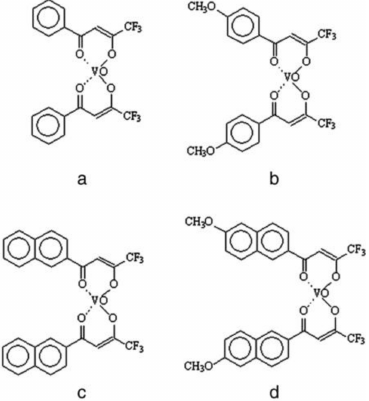
Figure 1. Structural formulas of complexes ( a – d ). ( a ) 1-phenyl-4,4,4-trifluorobutane-1,3-dione; ( b ) 1- (4-methoxyphenyl)-4,4,4-trifluorobutane-1,3-dione; ( c ) 1-(2-naphtyl)-4,4,4-trifluorobutane- 1,3-dione; ( d ) 1-(6-methoxy-2-naphtyl)-4,4,4-trifluorobutane-1,3-dione. Vanadyl complexes were synthetized and characterized as described by Sgarbossa et al.